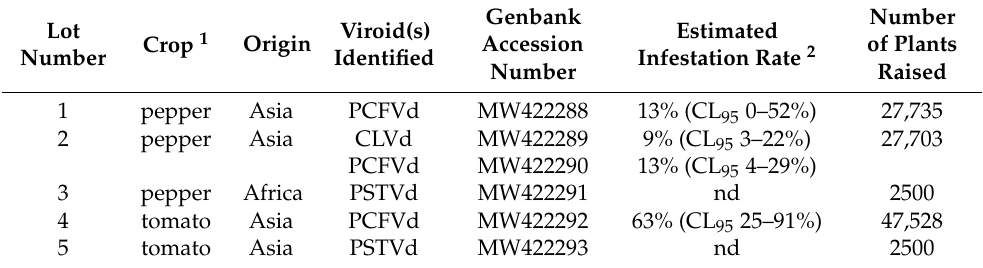
Table 1. Seed lots used for grow-out trials to determine the transmission from seeds to seedlings.